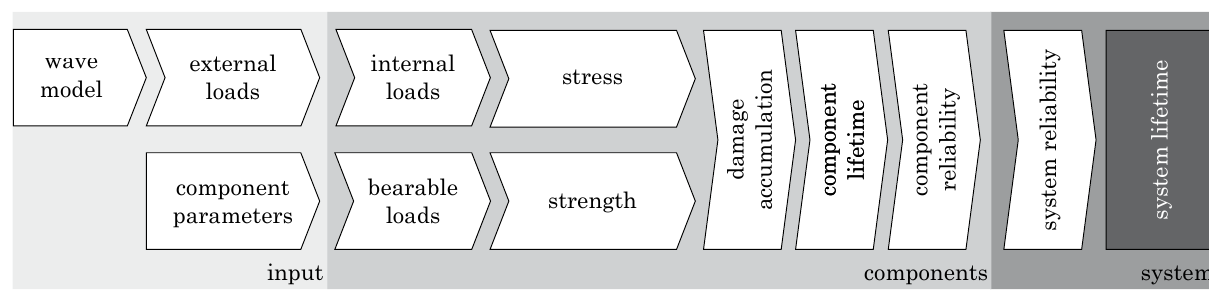
Figure 3: Reliability calculation approach